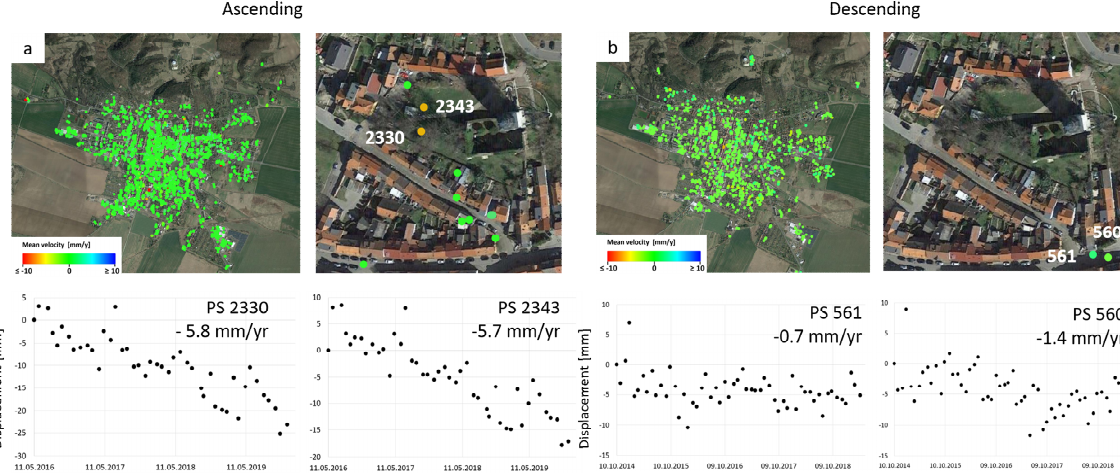
Figure 3: Velocity maps of Bad Frankenhausen for a) ascending (2016-2019) und b) descending (2014-2019)